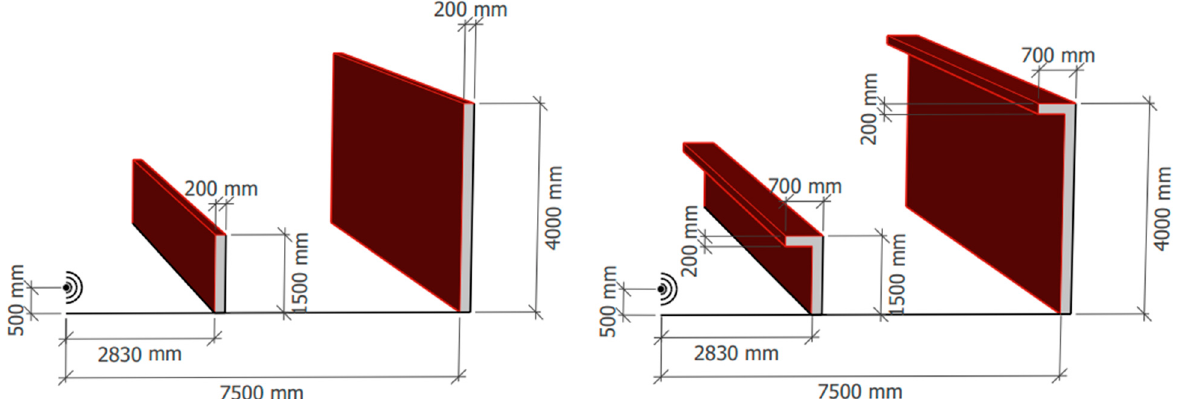
Figure 9. Schematic representation of the studied scenarios, including vertical ( left ) and L-shaped ( right ) barriers, with or without sound absorption. Red surfaces correspond to possible sound absorption areas.